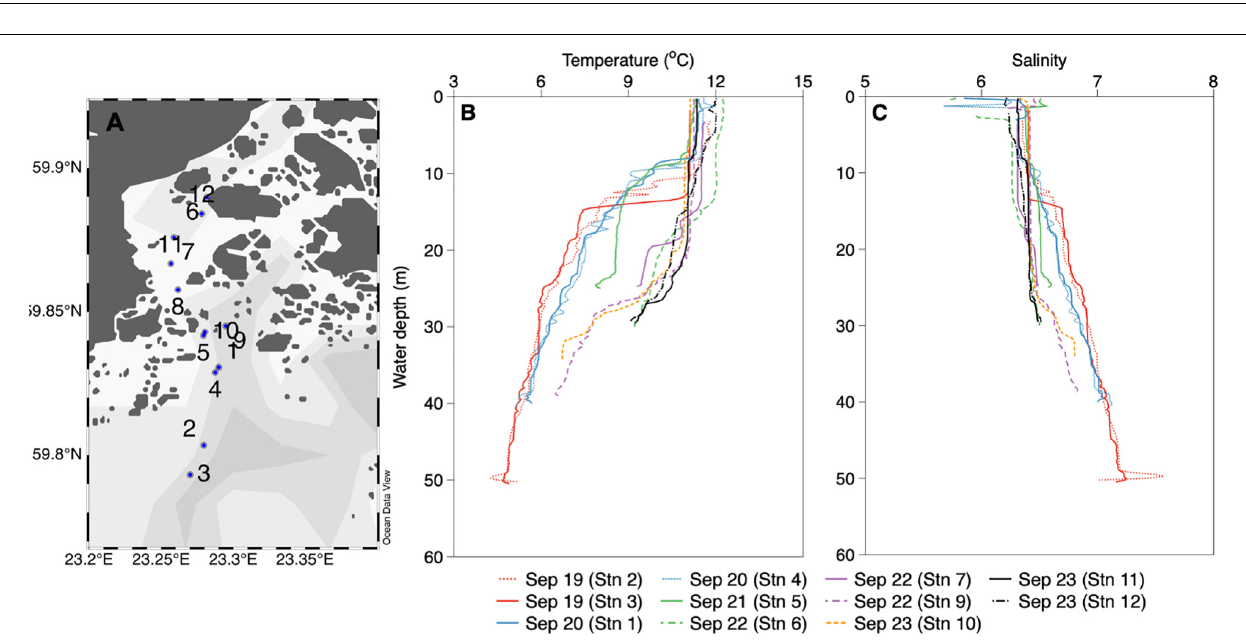
FIGURE 9 | Ventilation of the upper mixed layer in TZS coastal waters (A) by the storm event as demonstrated by vertical temperature (B) and salinity (C) profiles taken between 19 and 23 September 2018; position of individual CTD casts are indicated by station numbers in (A) .